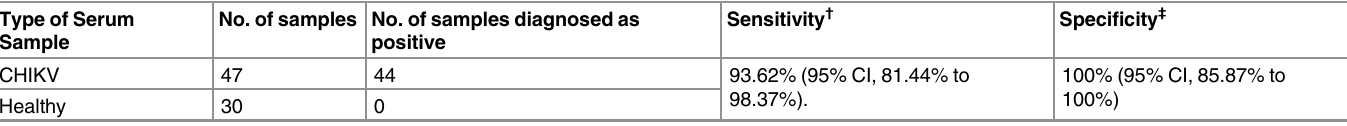
Table 2. Performance of DANP-ANCHORED on Serum samples. Type of Serum